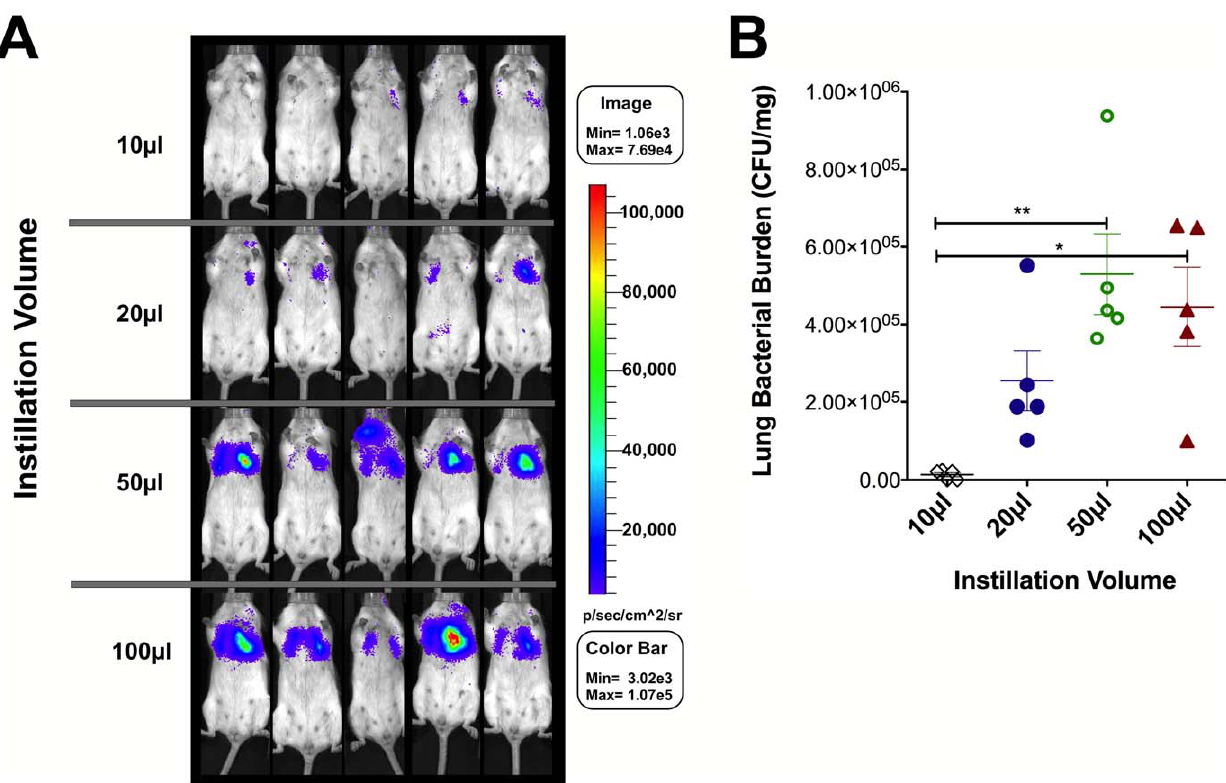
Figure 2. Correlation between whole animal invivo imaging with viable bacterial counts 24 hours after challenge. BALB/c mice (5/ group) were challenged with 1 6 10 6 CFU of FTLVS bearing the pXB173-lux reporter plasmid via the intranasal route in a total bolus volume of either 10 m l, 20 m l, 50 m l, or 100 m l. Panel A : Dissemination of FTLVS was then monitored 24 hrs later using an IVIS Spectrum whole animal imaging system. Images were collected at the indicated time points post-infection and were normalized to reflect photons per second per cm ‘ 2/sr. ( Panel B ): Lungs were collected after imaging was completed for bacterial burden determination via dilution plating. Statistical analyses were performed via one-way ANOVA using a Bonferroni multiple comparisons posttest. Statistically significant differences are indicated as follows: p , 0.05 (*) and p , 0.01